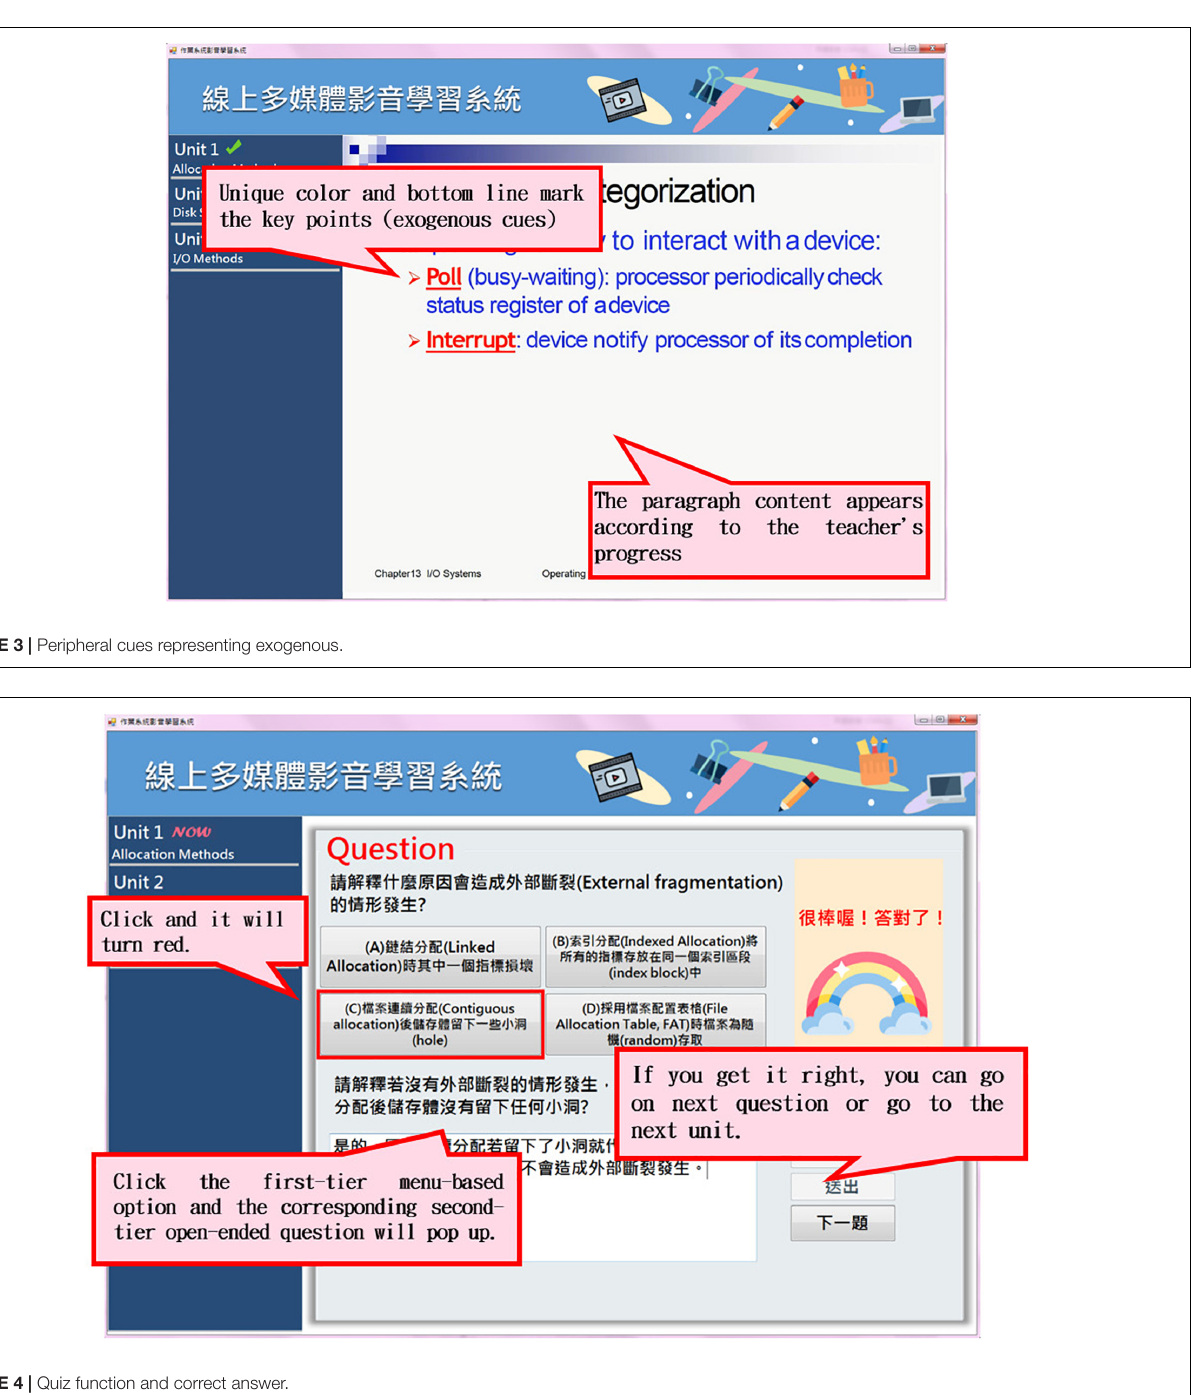
FIGURE 4 | Quiz function and correct